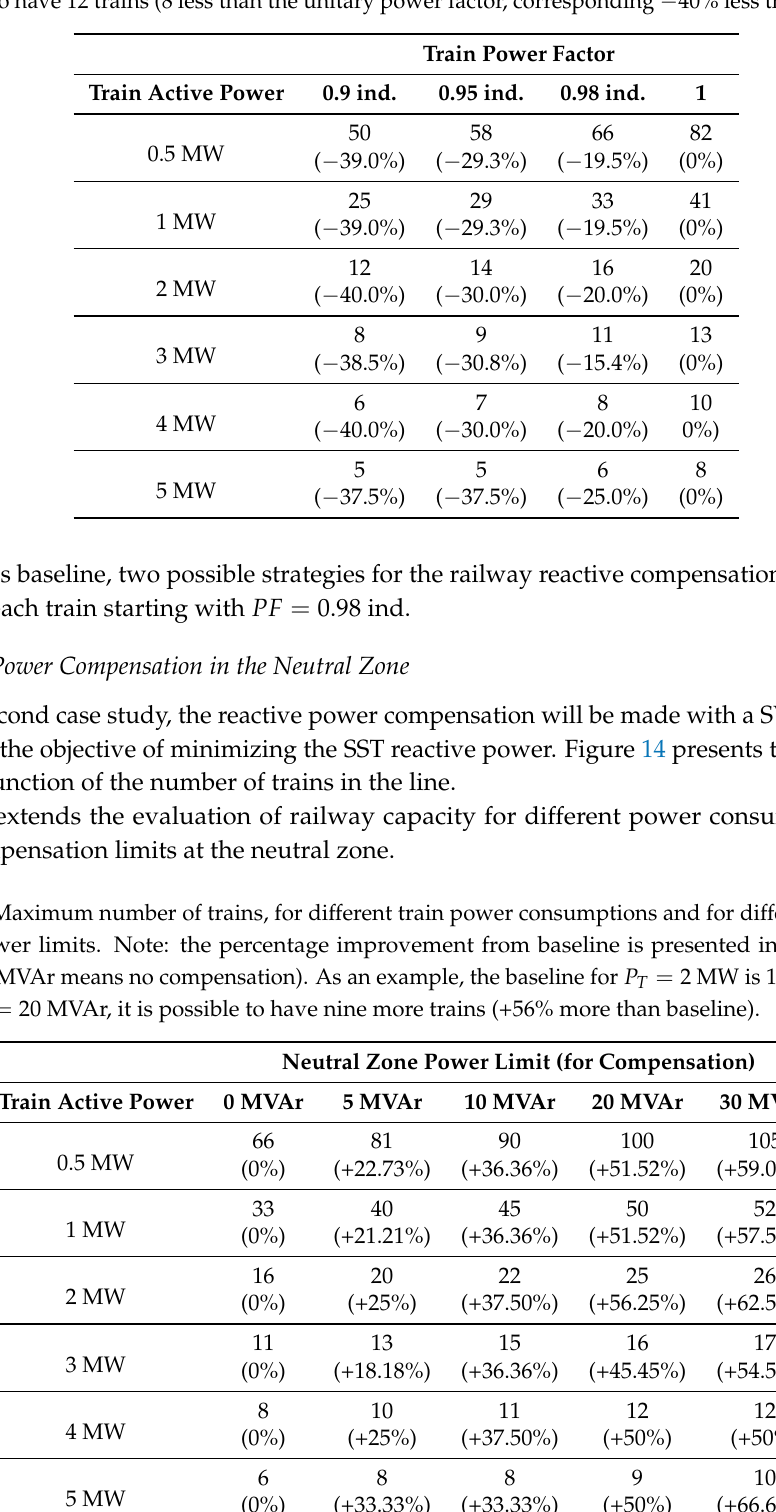
Table 1. Maximum number of trains, for different train power consumptions and for different train power factors. Note: the percentage reduction from unitary power factor is presented in parentheses. As an example, the baseline for P T = 2 MW and PF = 1 is 20 trains; then, for PF = 0.9 ind., it is only possible to have 12 trains (8 less than the unitary power factor, corresponding − 40% less than baseline).